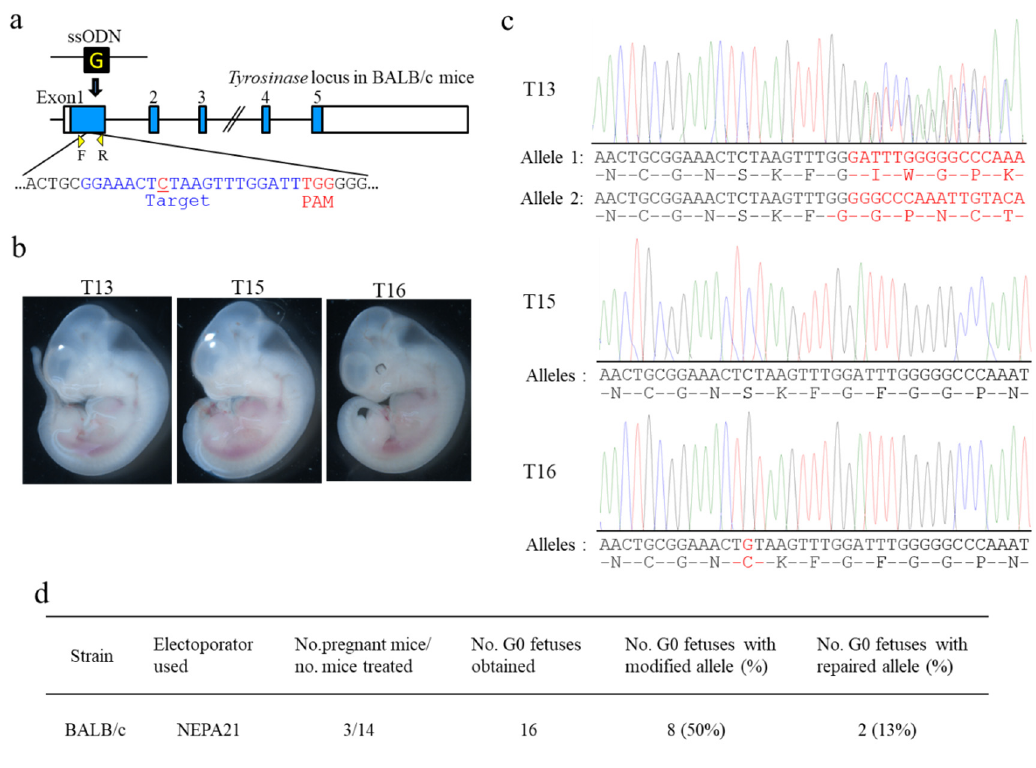
Figure 3. i -GONAD-based KI of a wild-type sequence into the tyrosinase gene ( Tyr ) in BALB/c mice using NEPA21 electroporator under the electric conditions of Tp 40 V, 162 Ω (on average), and ≈ 100 mA. ( a ) Gene structure of Tyr in BALB/c mice. BALB/c mouse has a mutated nucleotide “C” (shown in red) in the sequence of exon 1 of Tyr . The donor single-stranded oligodeoxynucleotide (ssODN) contains wild-type nucleotide “G” at the same position corresponding to mutated nucleotide “C” because the target nucleotide “G” is a key nucleotide for tyrosinase activity, and thus nucleotide replacement at this position often causes an albino phenotype. Primers F and R used for amplification of a region spanning the target sequence are shown below the Tyr . PAM is shown in red. Blue color in each exon encodes tyrosinase protein. ( b ) Mid-gestational fetuses (T13, T15, and T16) obtained from i -GONAD-treated plug-positive BALB/c females. Notably, the T16 fetus exhibited depigmented eyes, suggesting successful KI of ssODN. ( c ) Direct sequencing of PCR products derived from the fetuses shown in (b). T15 fetus showing depigmented eyes had mutated alleles. T13 fetus showing depigmented eyes is judged as heterozygous bi-allelic KO because both alleles had indels, each yielding different frameshifts of amino acids (shown by red). The T16 fetus is judged as homozygous bi-allelic KI because both alleles had wild-type nucleotide “G” (shown by red), a key nucleotide for tyrosinase activity. ( d ) Genome editing efficiency of the Tyr locus at BALB/c strain .